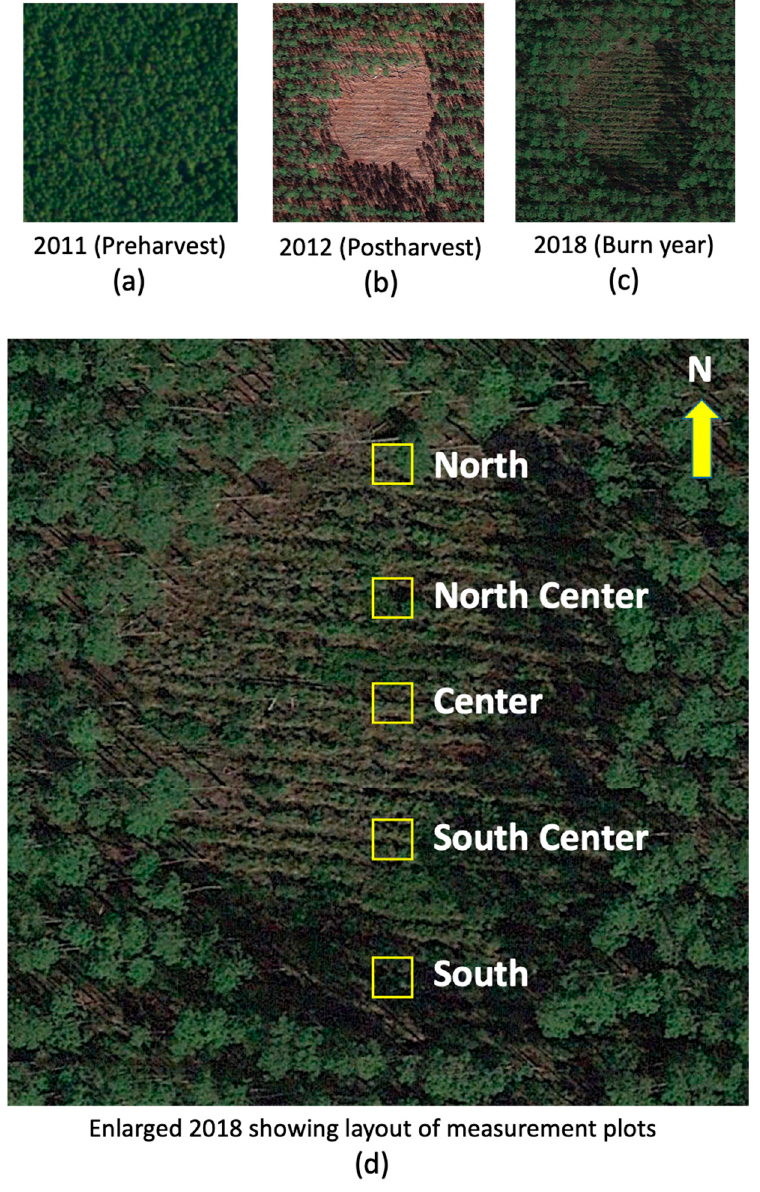
Figure 2. Stand history (a–c) and measurement plot positions (d) at the Tate’s Hell site.